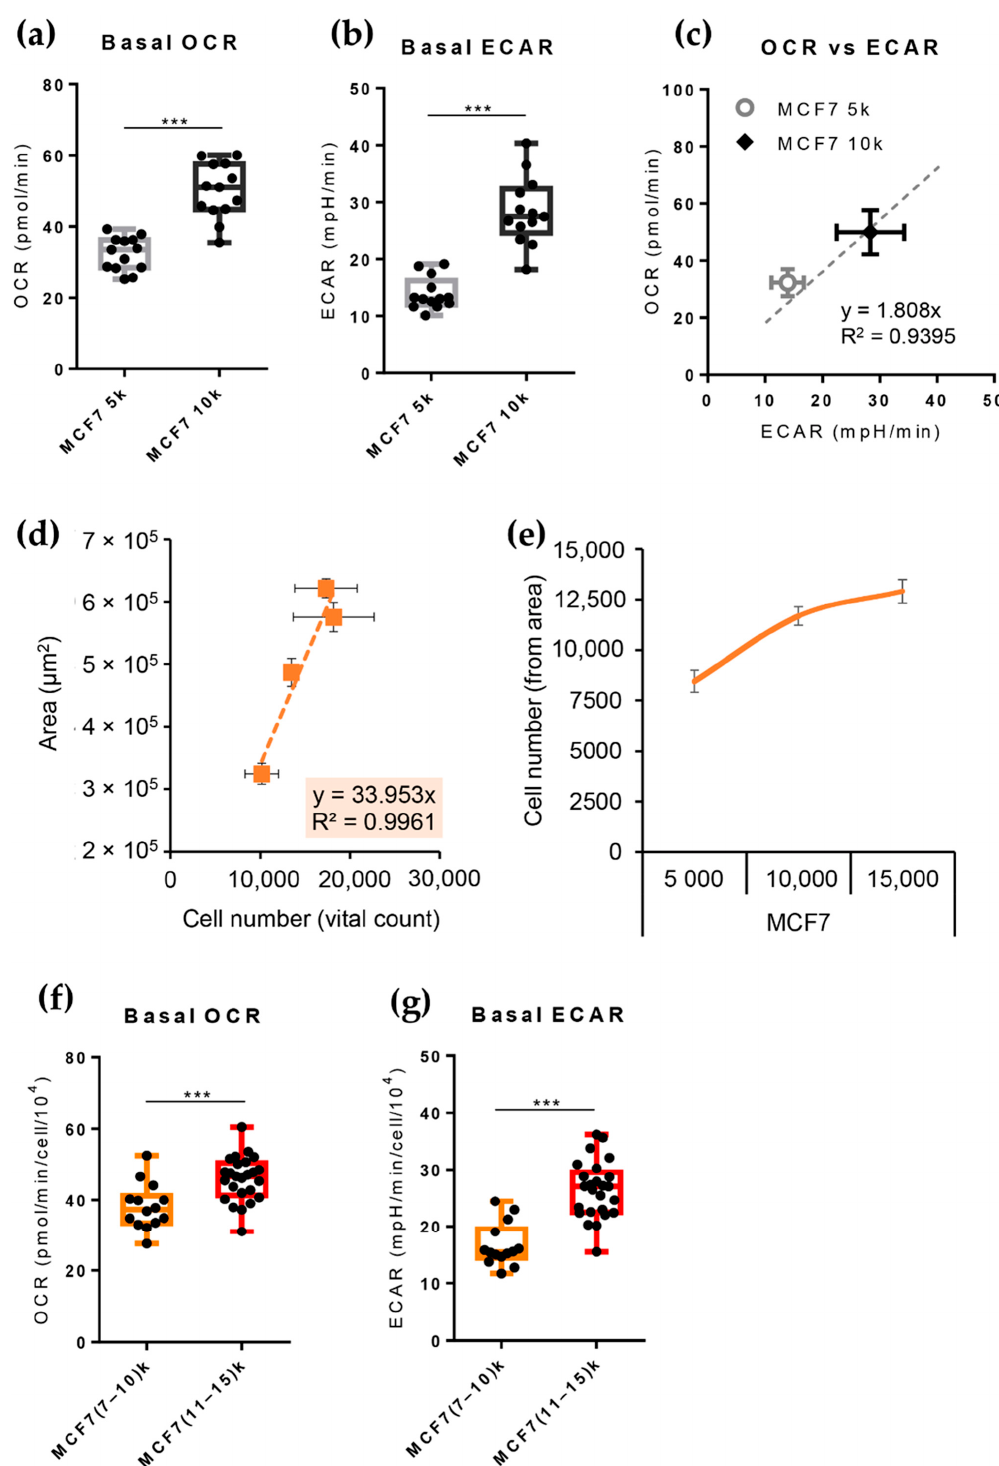
Figure 3. Basal bioenergetic analysis of spheroids obtained with the Single Spheroid Protocol , seeding a different number of MCF7 cells per well, and subsequent application of an area-mediated nor- malization approach. ( a , b ) Box and whisker plots of basal OCR ( a ) and basal ECAR ( b ) values of spheroidsobtained seeding 5000 (5 k) cells and 10,000 (10 k) cells per well. Statistical test: unpaired t -test, *** p > 0.001. ( c ) Correlation of OCR and ECAR values (MCF7 5 k n = 15, MCF7 10 k n = 15); points represent mean ± standard deviation along with regression line. Statistical test: linear re- gression. ( d ) Standard curve obtained measuring the area of groups of MCF7 spheroids